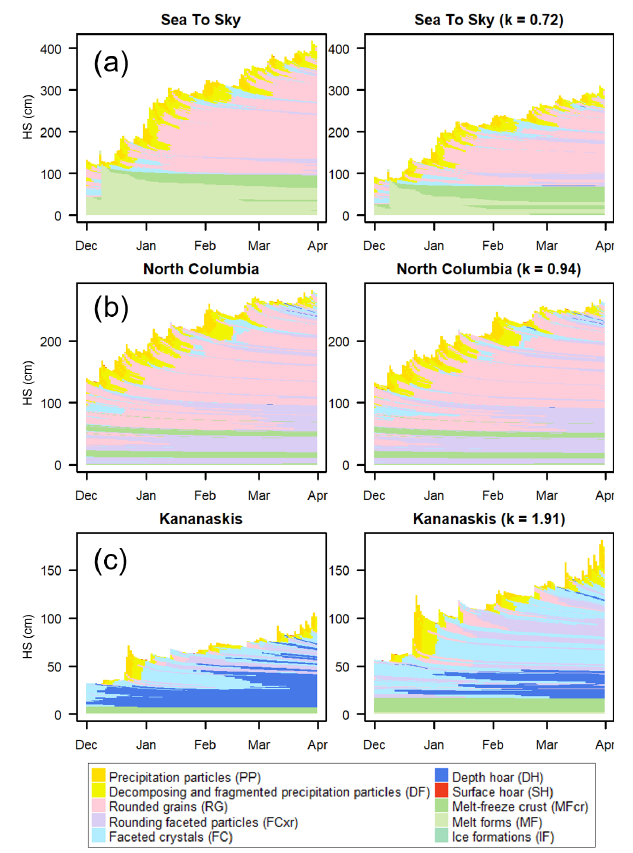
Figure 9. Timelines of simulated snowpack structure before and after precipitation adjustments at locations in (a) the Sea to Sky region where modelled snow depths were much larger than upscaled observations, (b) the North Columbia region where the modelled and upscaled observation snow depths closely agreed, and (c) the Kananaskis region where modelled snow depths were much smaller than upscaled observations. Snowpack layers are colour-coded by grain type following Horton et al. (2020a).